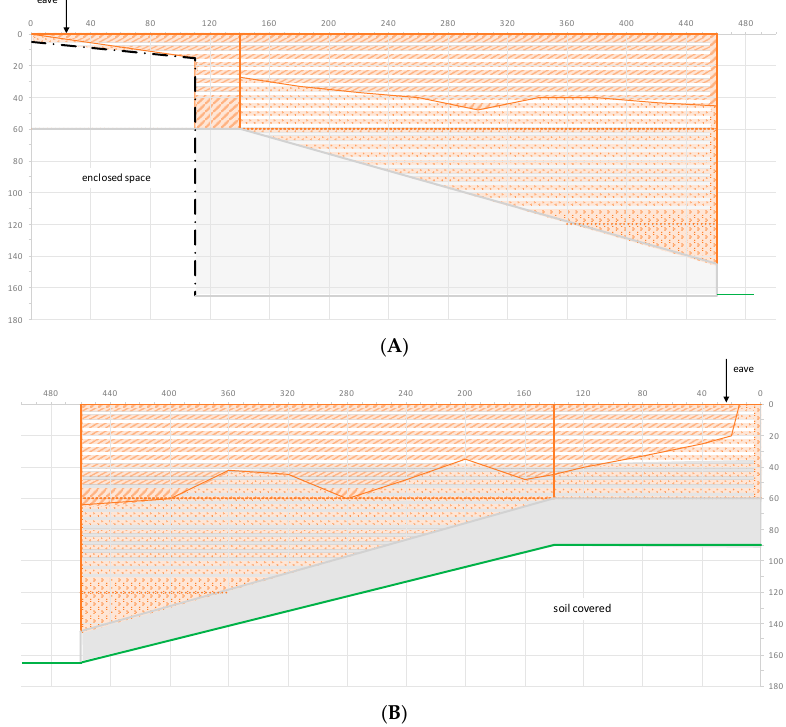
Figure 15. Schematic representation of the observed decay of wall 2: ( A ) eastern face; ( B ) western face. For the legend, see Figure 13.